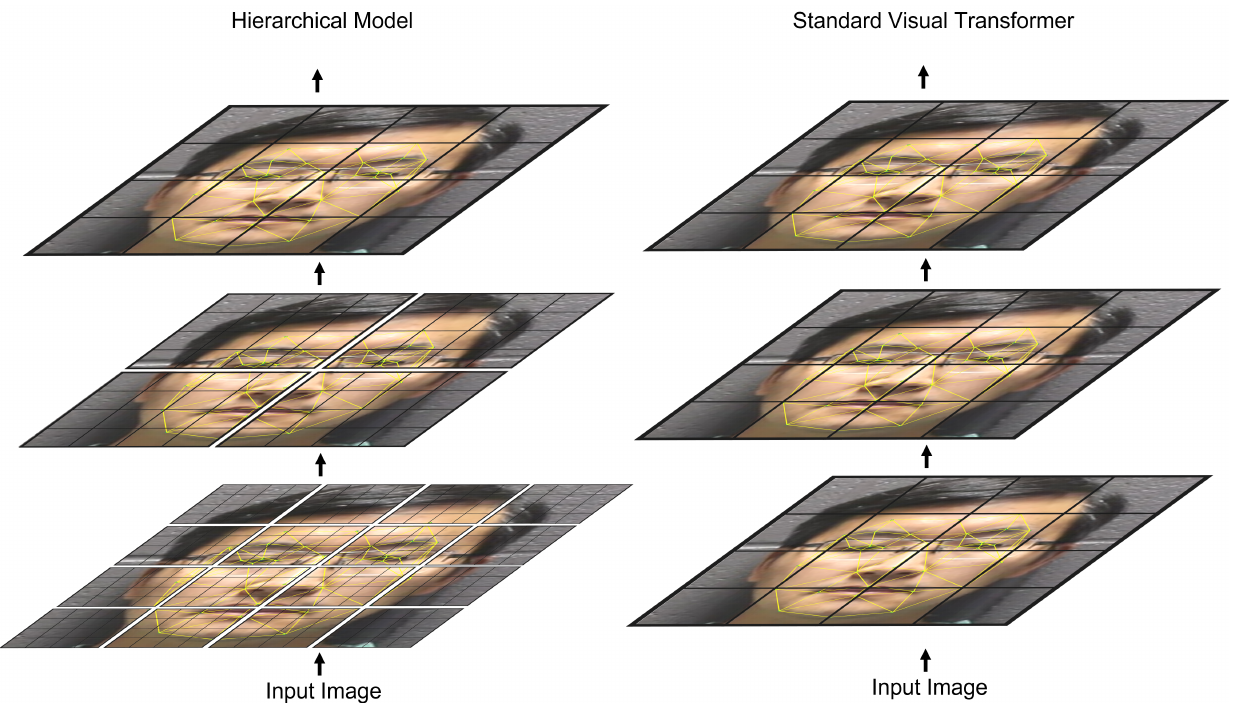
Figure 1. Comparison of the hierarchical model ( left ) to standard visual transformer such as ViT ( right ). In the hierarchical model, the lower layers are embedded as a greater number of smaller patches. Attention for these patches is only calculated within the local patch windows. As the image embedding progresses through the model, patches are gradually merged, and patch windows are expanded to allow for global